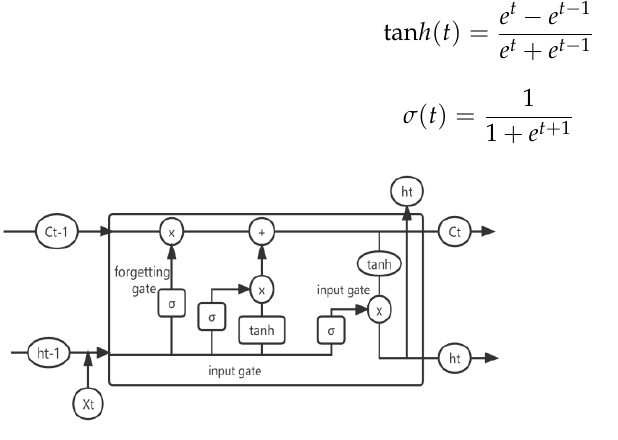
Figure 4. LSTM network structure.